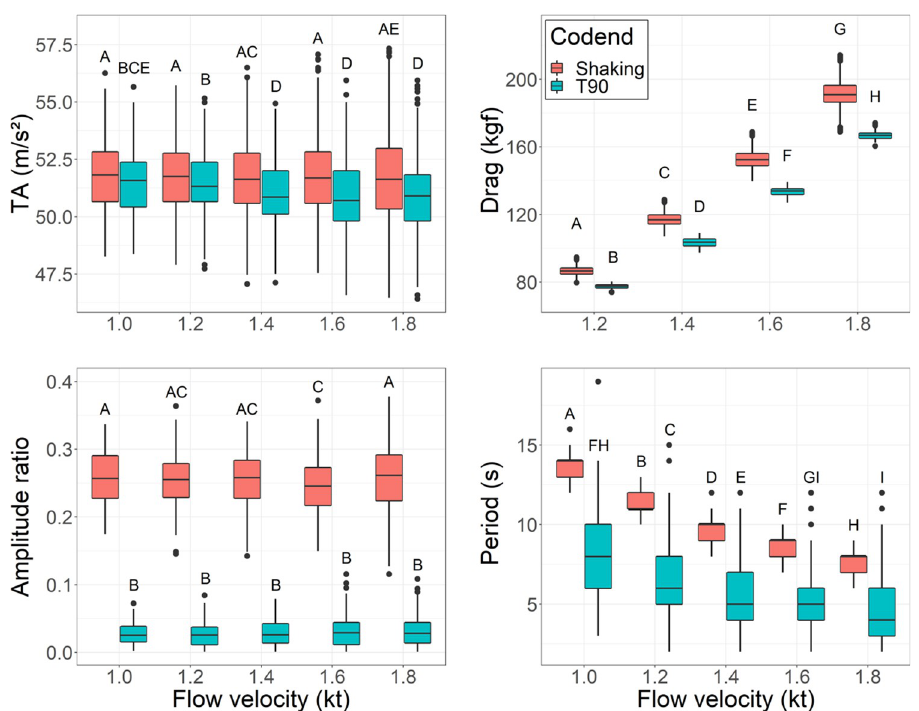
Fig 5. Boxplots of total acceleration, amplitude ratio, and period for codends evaluated in a flume tank test. The horizontal line in the middle of the boxes represents the 50 th percentile (median) the top and bottom limit of the boxes represents the 75 th percentile and 25 th percentile, respectively. Upper and lower whiskers are the 75 th (or 25 th ) percentile − 1.5 � interquartile range. Circles are values outside the range of the whiskers. Letters represent a significant difference between treatments (shaking or T90 codend) at a specific water velocity via post hoc analysis at an α of 0.05.